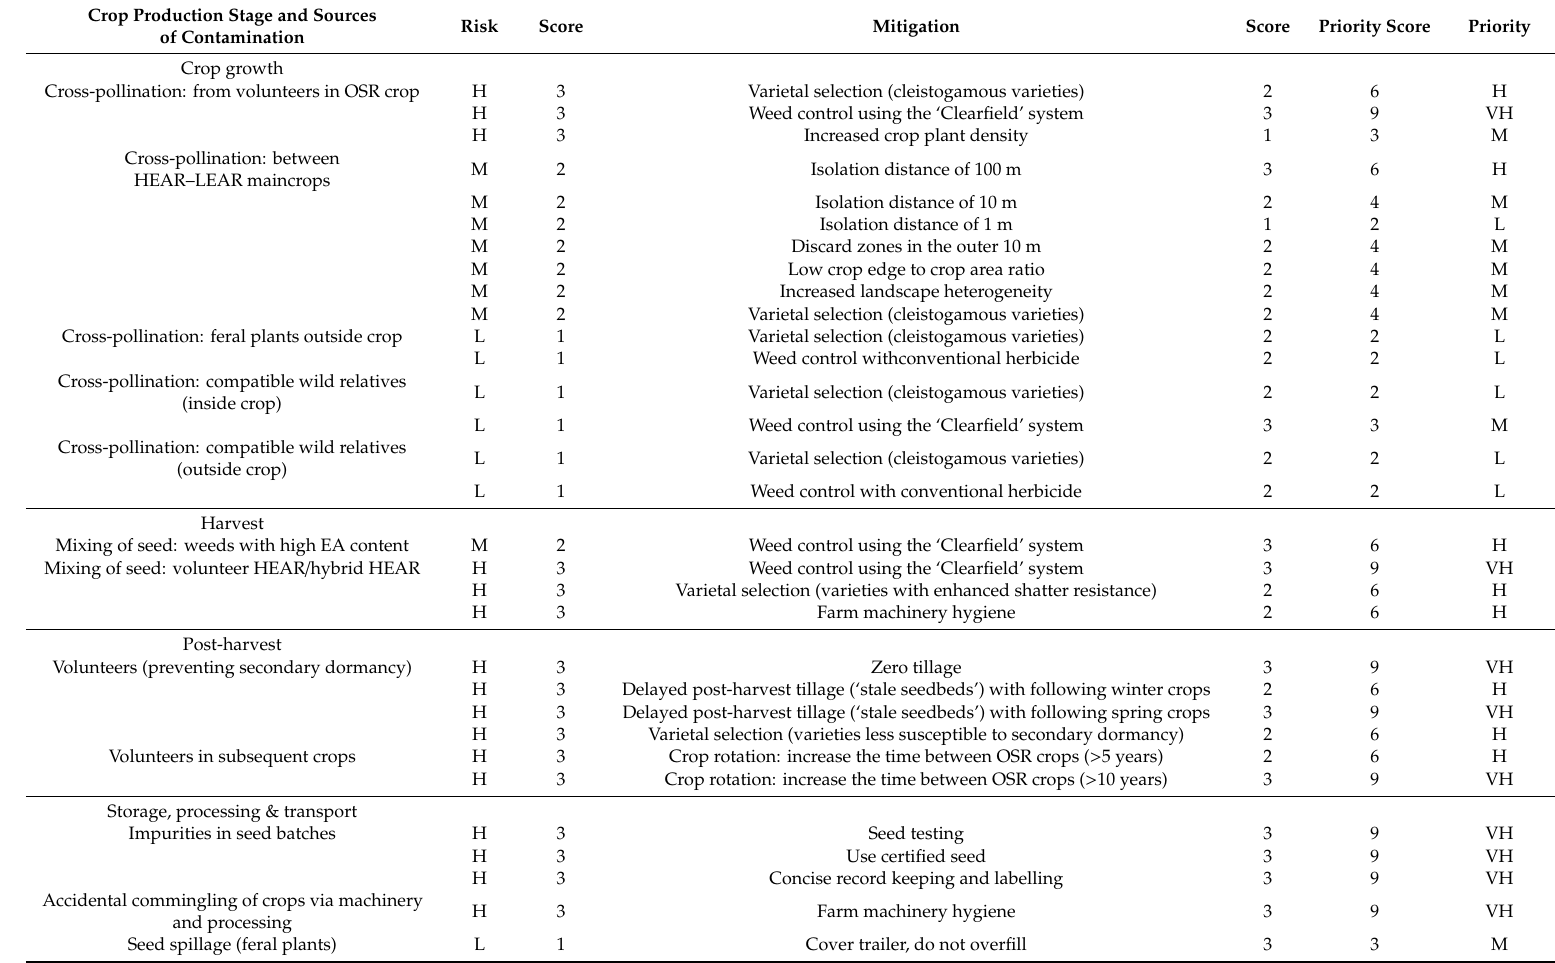
Table 3. HEAR–LEAR risk and mitigation